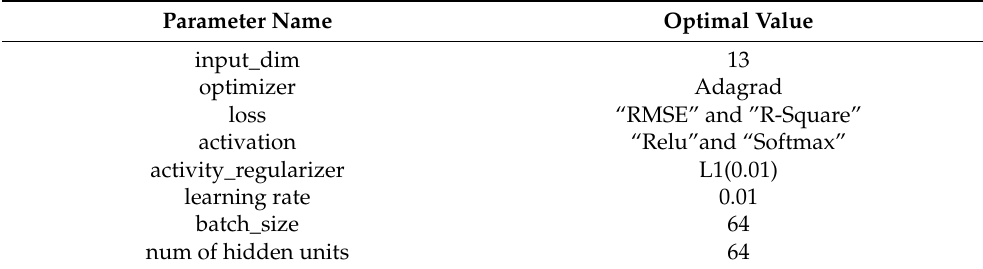
Table 2. Optimal parameters of the MA-LSTM model gained by grid search.